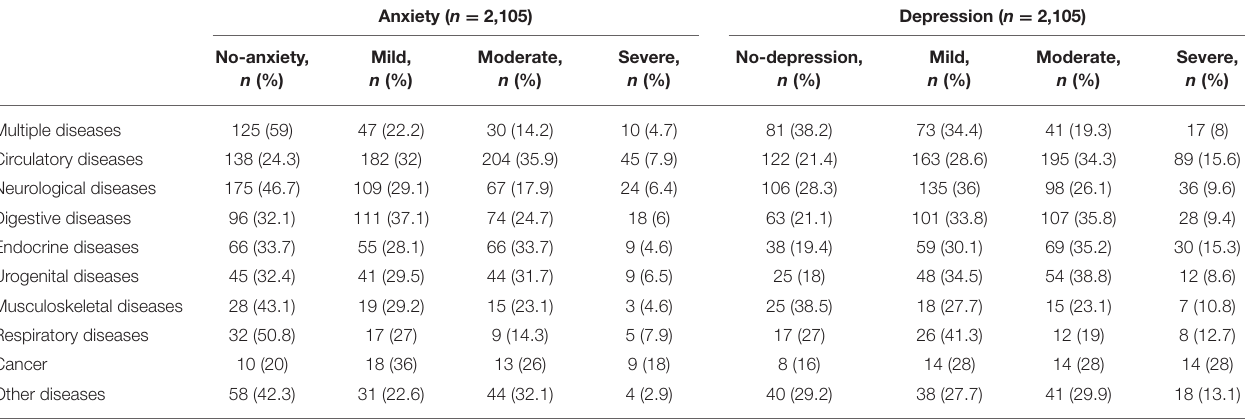
TABLE 3 | Severity of anxiety and depression in patients with various diseases.